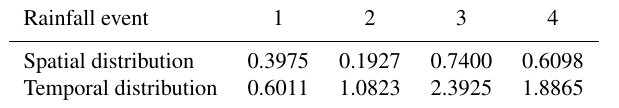
Table 3. C v values for the four storm events. Rainfall event 1 Spatial